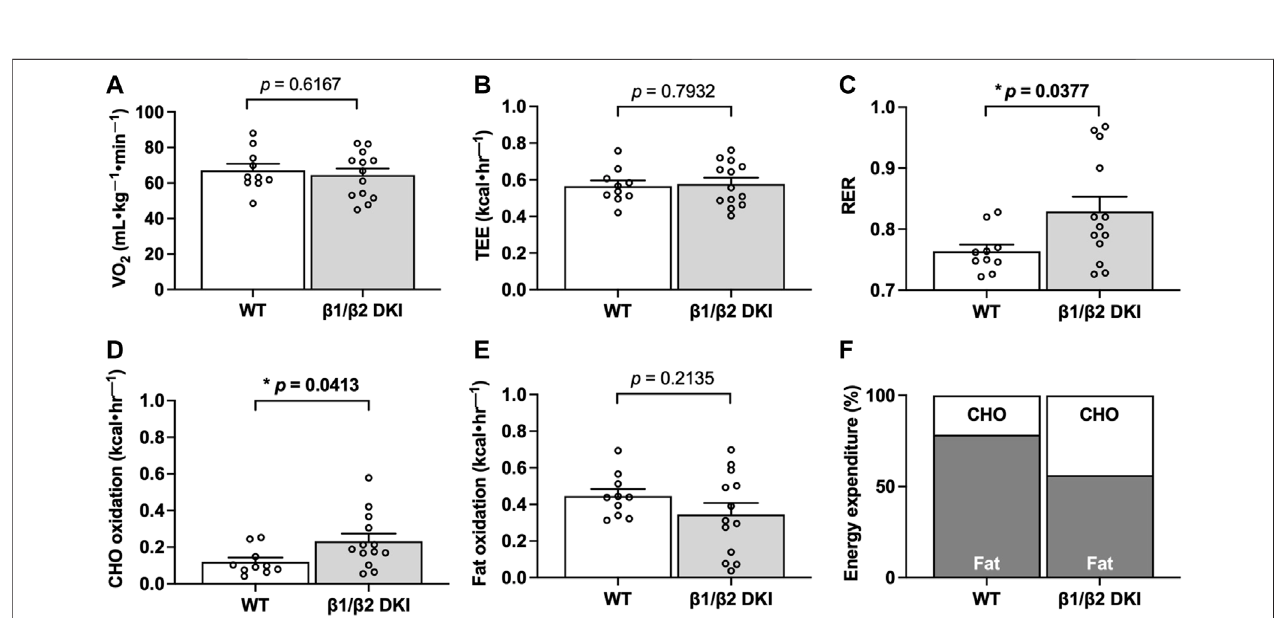
FIGURE 2 | DKI mice have increased respiratory exchange ratio (RER) and carbohydrate (CHO) oxidation rates during exercise calorimetry experiments. Respiratory gases (VO 2 and VCO 2 ) were measured every min and used to calculate RER, total energy expenditure (TEE), and substrate utilization during exercise calorimetry treadmill running at 60% ofindividual maximal running speed. Data presented are theaverage over the fi nal5 min ofexercise. (A) VO 2 ; (B) TEE; (C) RER; (D) CHO oxidation rates; (E) Fat oxidation rates; (F) Percent contribution of fat and CHO oxidation rates to TEE. Male mice, 17 – 20 weeks, n = 11 – 13. * p < 0.05.